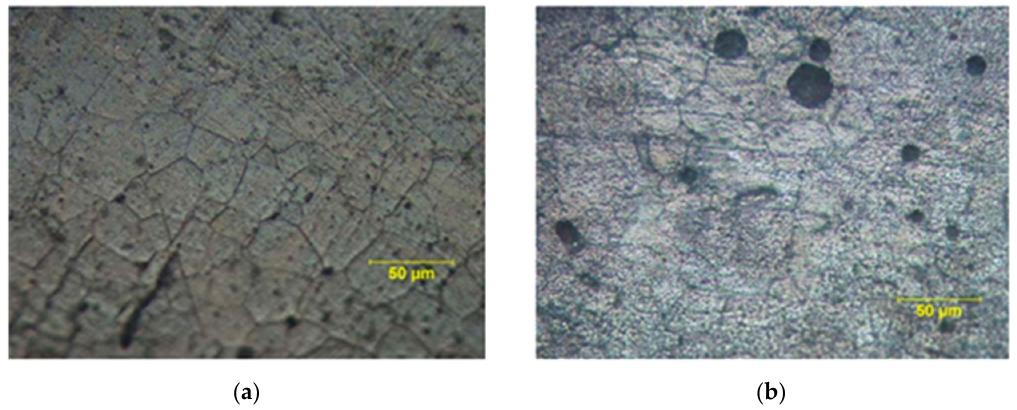
Figure 6. Optical microscopy images of WE43-T5 ( a ) before the 1st day and ( b ) after the 7th day.